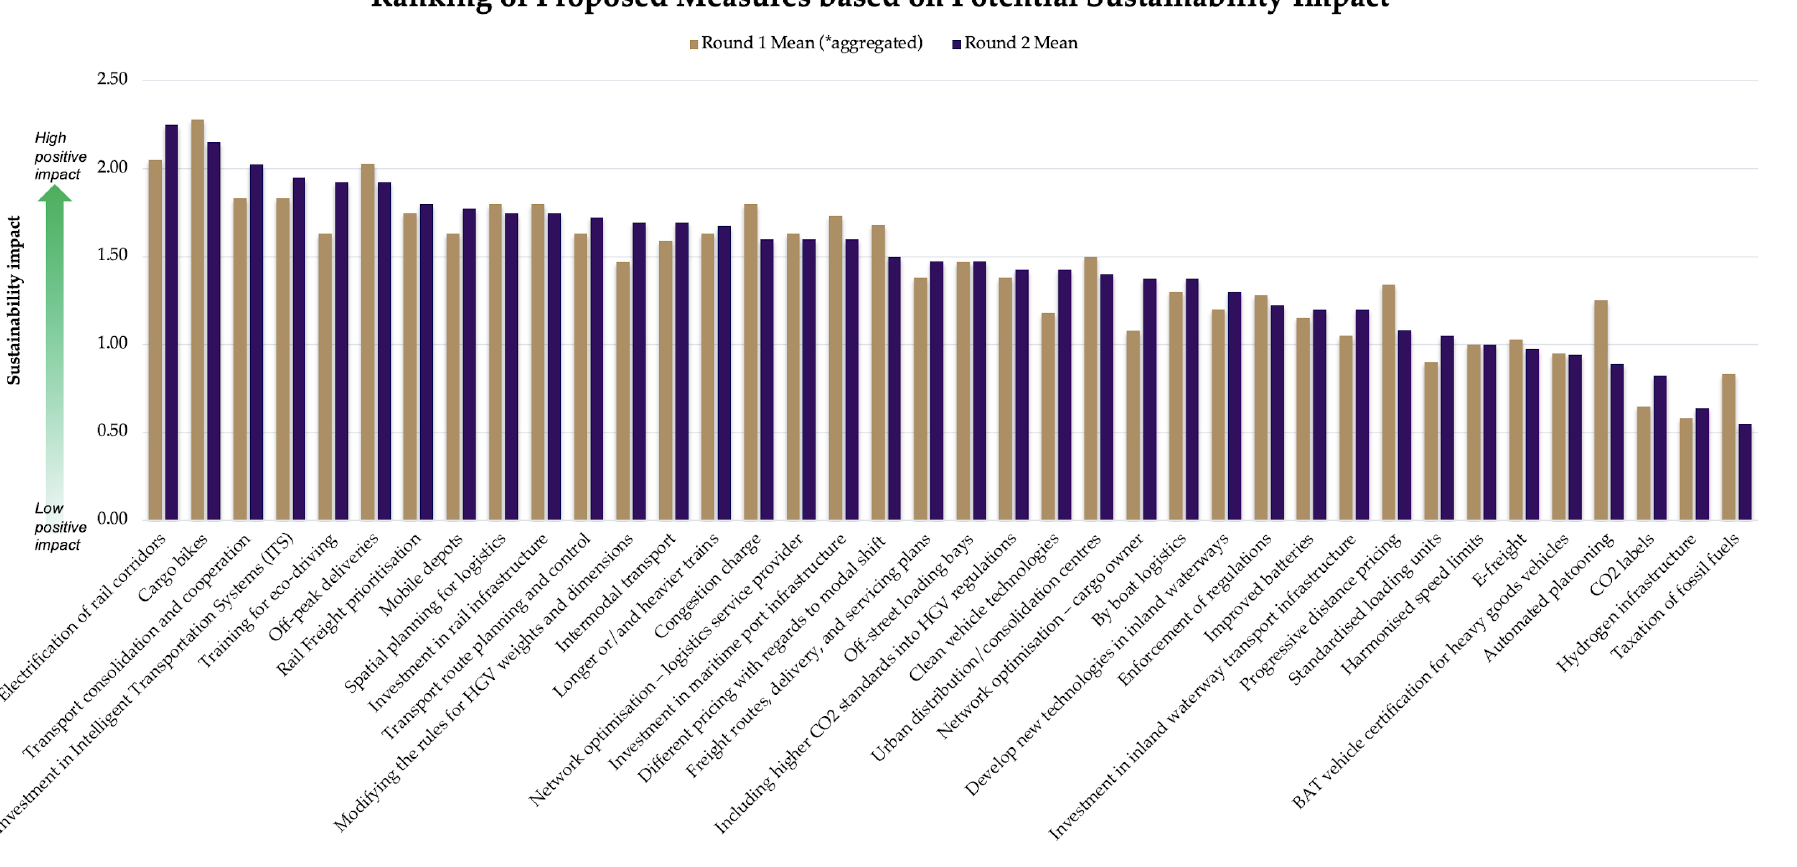
Figure 2. Proposed freight transport policy measures ranked by their potential impact on sustainability (Round 1 and Round 2 results). Note: Rating scheme where ‘3’ = strong positive impact; ‘ − 3’ = strong negative impact.